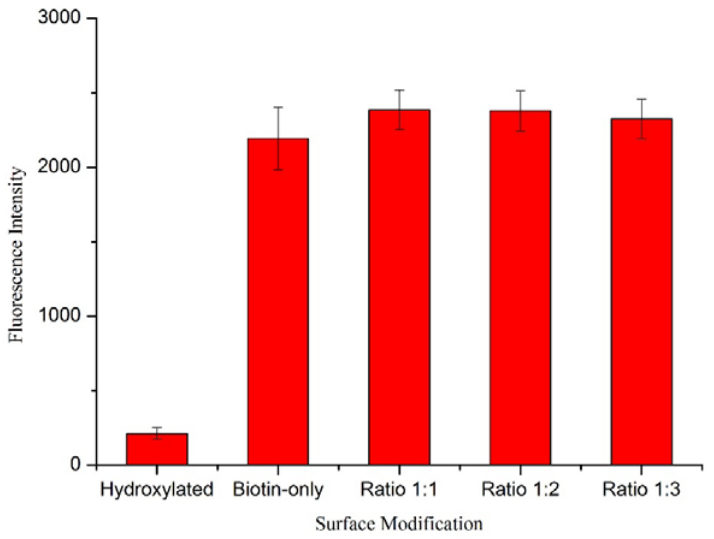
Figure 10. Mean fluorescence intensity (±standard deviation) of functionalized wafers. Five regions of 256 by 256 pixels were measured on each fluorescence image with an Olympus IX 70, and three images were taken for each group of wafers.